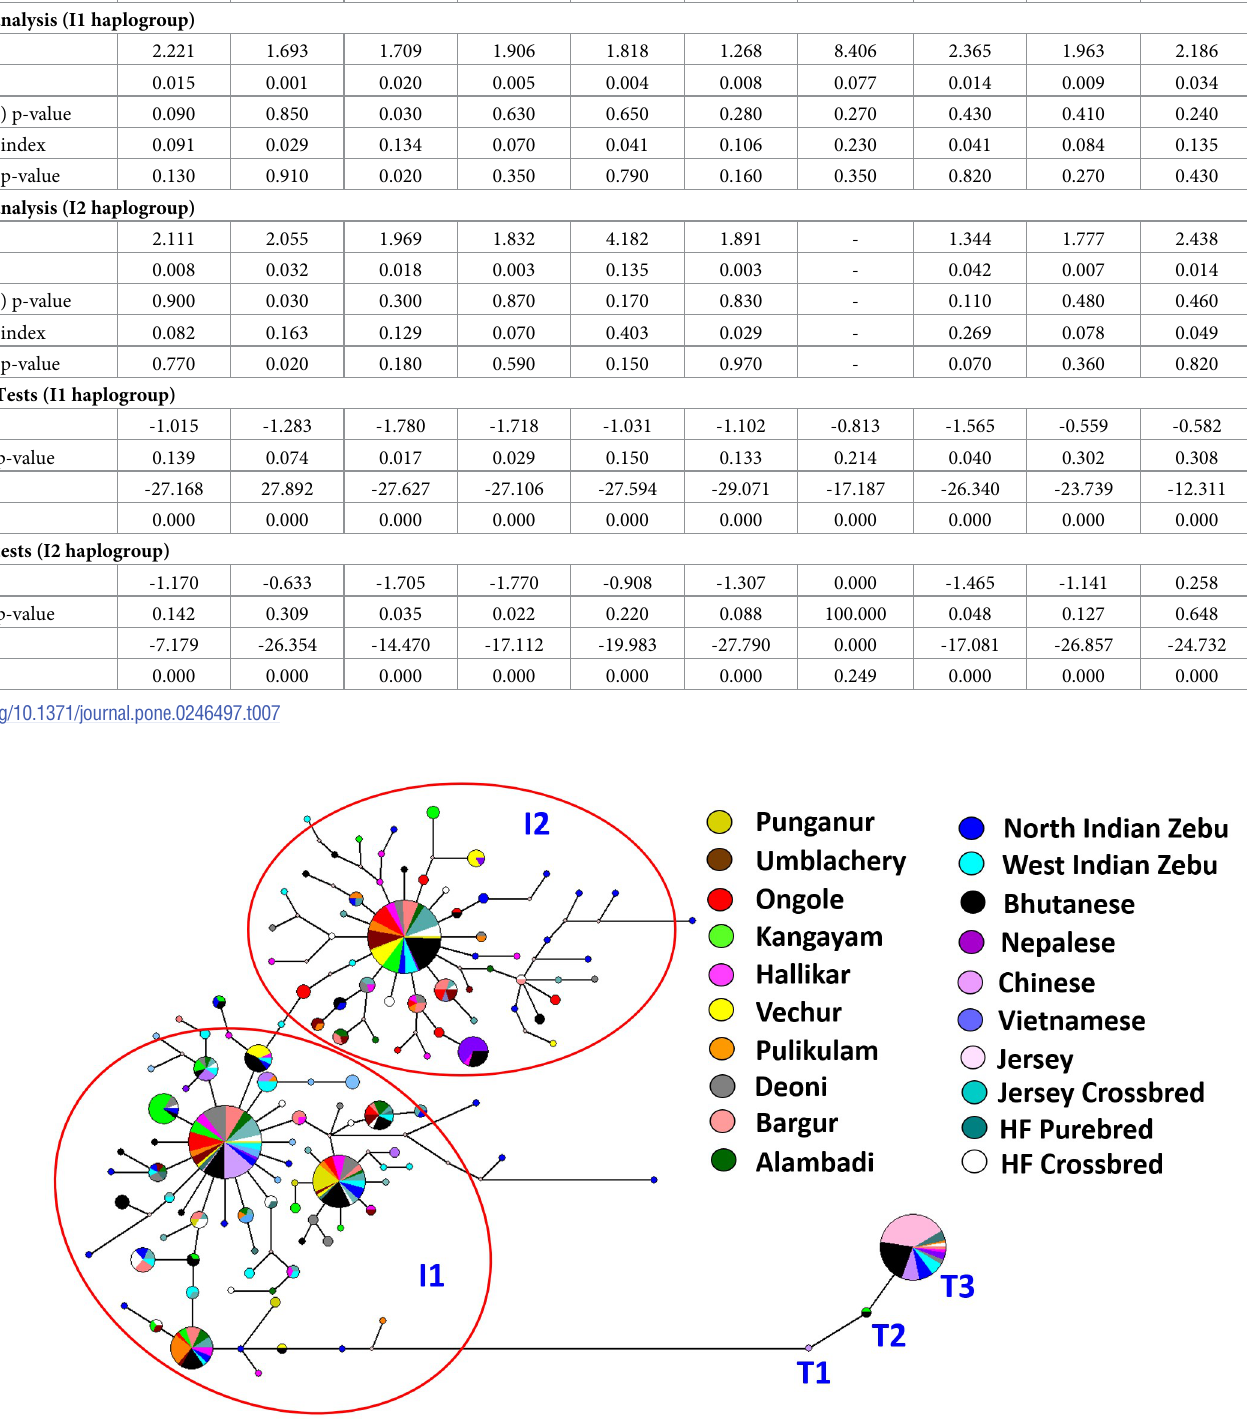
Table 7. Tests for demographic expansion based on mismatch analysis and neutrality in South Indian draught type Zebu cattle. Statistics